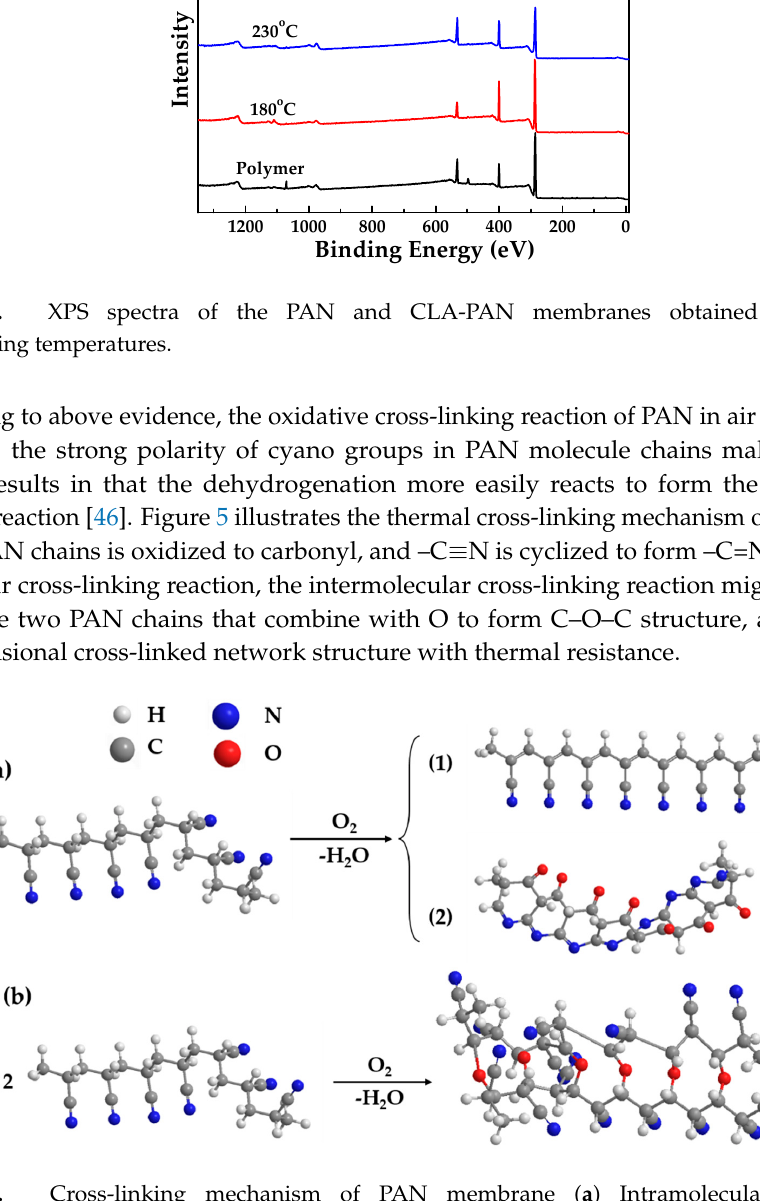
Figure 3. The C1s ( a ), O1s ( b ) and N1s ( c ) core levels of polymer membrane and CLA-PAN membranes prepared at different cross-linking temperatures.